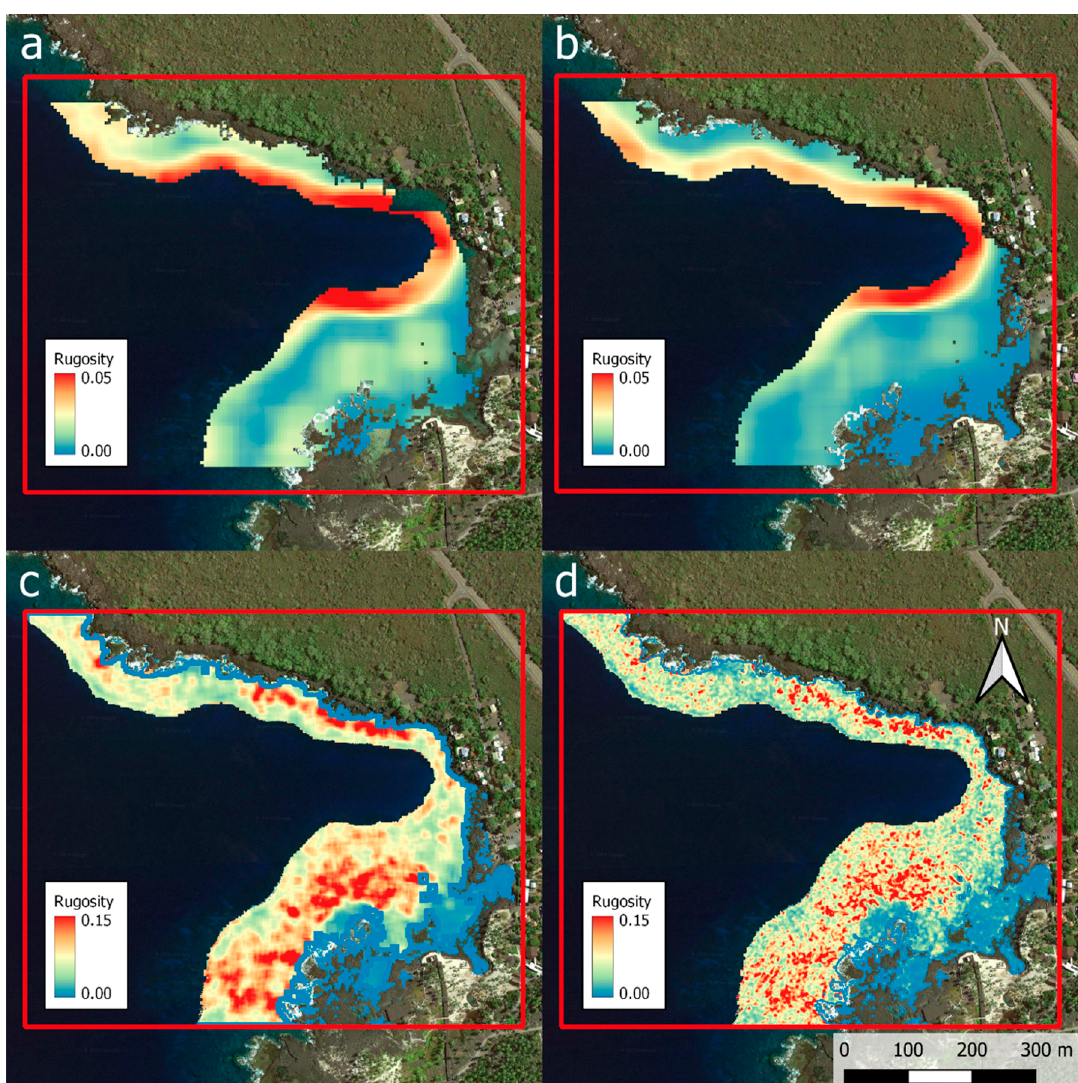
Figure 6. Reef rugosity using a 7-pixel moving window estimated water depth from ( a ) SHOALS (at native 6m spatial resolution) and ( b ) VSWIR imaging spectroscopy (averaged to 6m spatial resolution) in Honaunau Bay to 20 m ocean depth. These course-resolution rugosity maps are essentially maps of reef slope. For comparison, the high spatial resolution provided by the VSWIR spectrometer (65 cm) affords rugosity metrics at finer resolutions, shown here with ( c ) 21-pixel and ( d ) 7-pixel moving windows, which reveal coral colonies in red areas. Background satellite imagery © Google 2018.